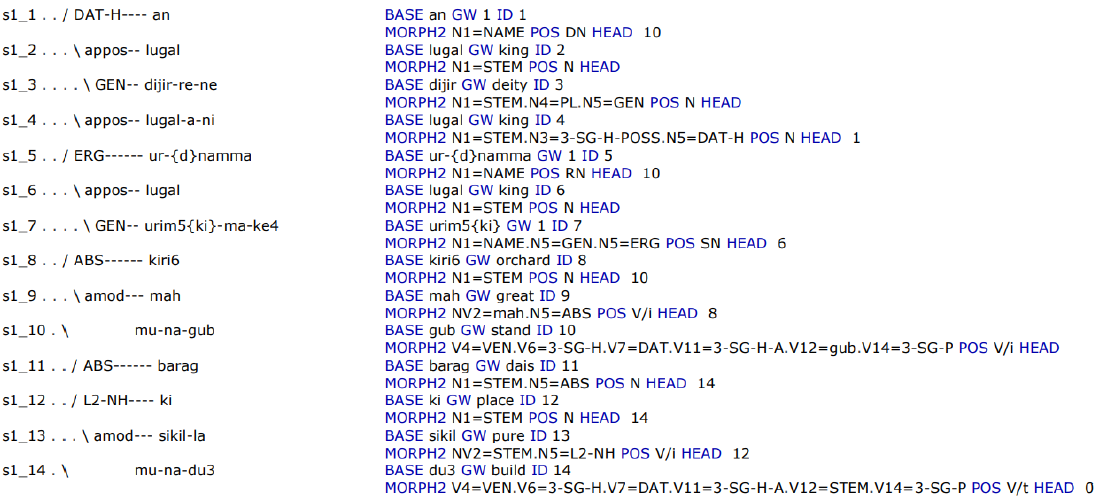
Figure 6. Syntactic pre-annotation of the Ur-Namma 5 inscription (http://oracc.iaas.upenn.edu/etcsri/